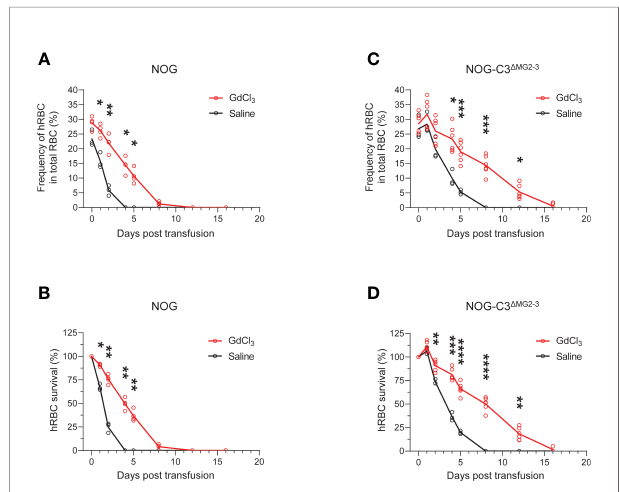
FIGURE 5 | Prolonged survival of hRBCs in NOG-C3 D MG2-3 mice treated with GdCl 3 . NOG and NOG-C3 D MG2-3 mice were treated with GdCl 3 four times at 3 – 4-day intervals. Mice were then transfused with hRBCs at 1 day after the last Clo-lip treatment. Frequencies (A, C) and survival rates (B, D) of transfused hRBCs in NOG mice (A, B) and NOG-C3 D MG2-3 mice (C, D) . The NOG group consisted of three saline-treated and four Clo-lip-treated mice. The NOG-C3 D MG2-3 group consisted of three saline-treated and six Clo-lip- treated mice. Asterisks indicate statistically signi fi cant differences between Clo-lip- injected mice and saline-injected mice as determined using two-way repeated- measures ANOVA (****p < 0.0001, ***p < 0.001, **p < 0.01, and *p < 0.05).